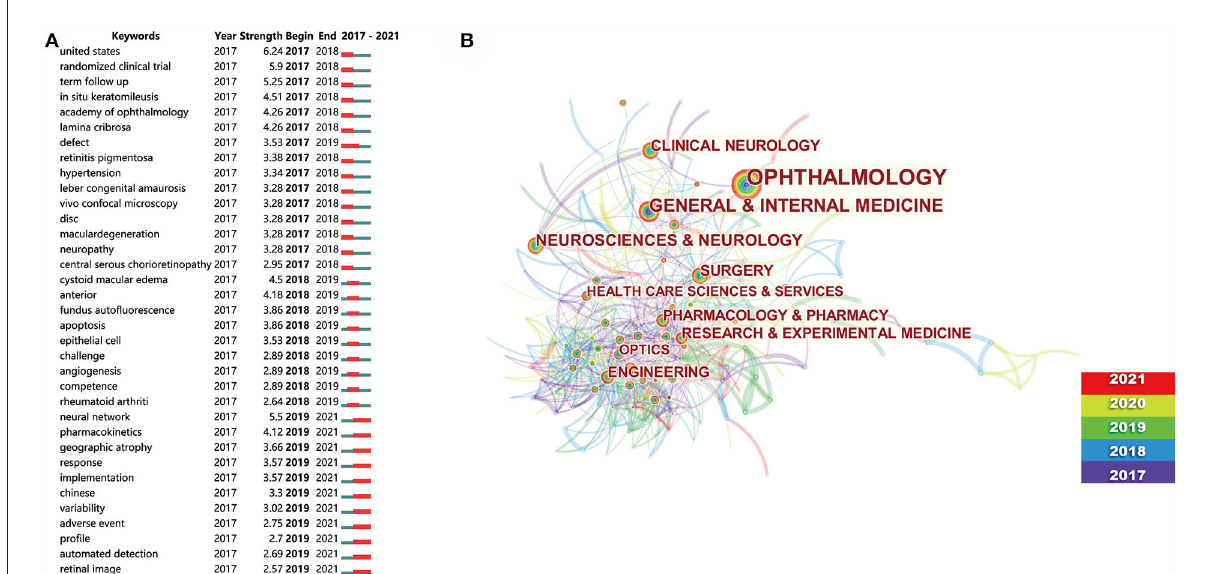
FIGURE3 Ophthalmology research trends analysis. (A) Keyword burst analysis. The red line indicates the year in which the burst of the corresponding keyword began and ended. (B) Subject category analysis. The larger subject categories indicate their greater frequency and importance, and the distance between subject categories indicates how closely they collaborate. The lines between subject categories indicate the collaboration between the subject categories at either end, with the color of the different lines representing the collaboration time in the different subject categories and the thickness representing the degree of collaboration closeness. The color of the temporal rings represents the occurrence of that subject category in different years, the thicker the corresponding temporal rings, the more frequently it occurs, with the time scale at the bottom